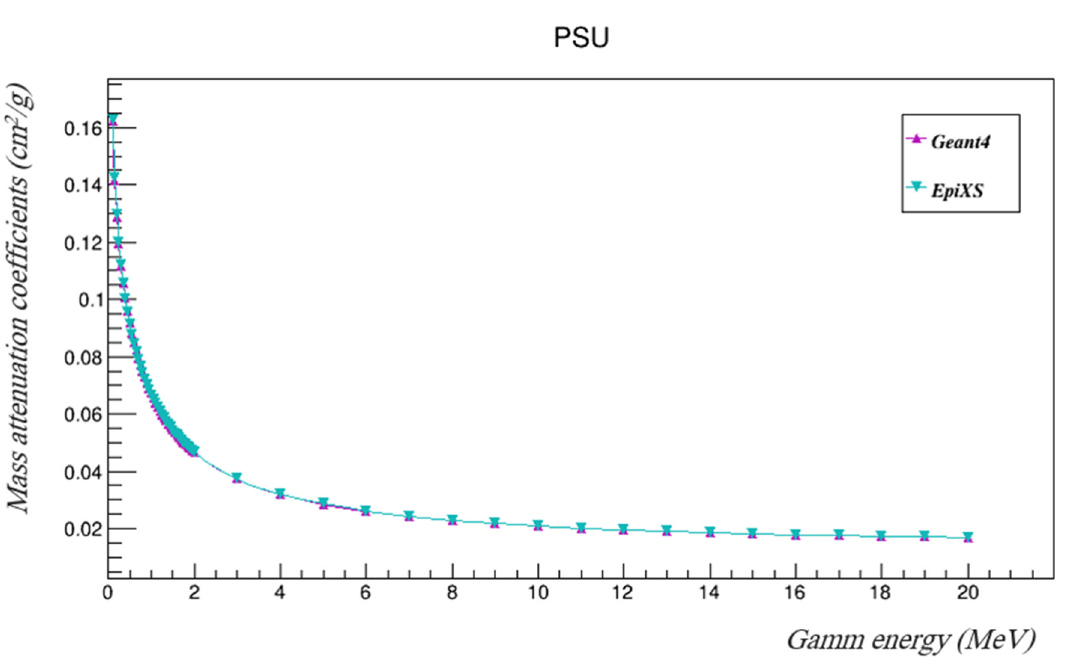
Figure 3 [23]. Table 2 tabulates the results and the percentage differences between the mass attenuation coefficients found using Geant4 and EpiXS, as calculated by Equation (14).